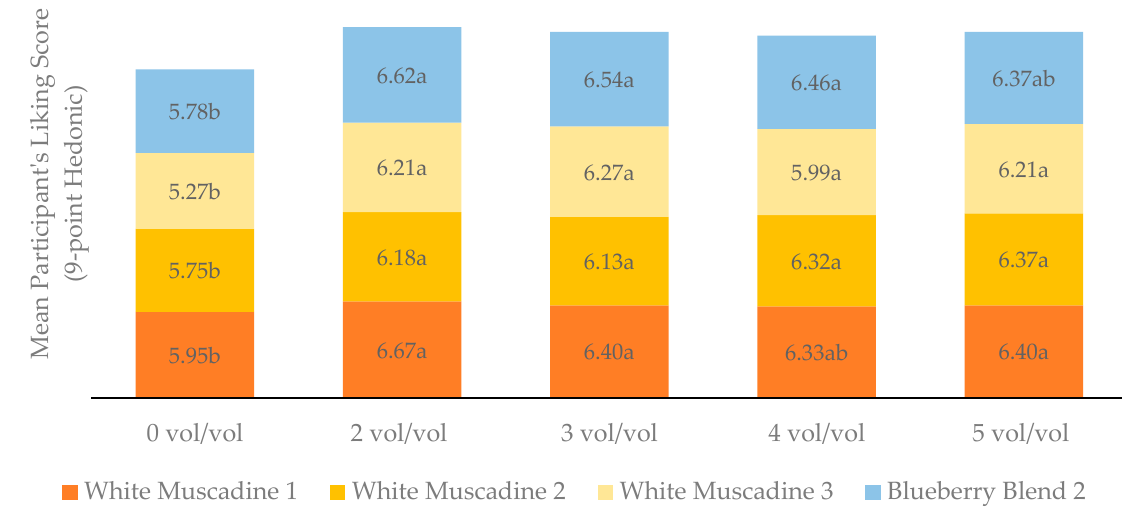
Figure 2. The mean liking using 9-point hedonic scale for each of the four Florida wines. a, b denotes statistical significance ( p < 0.05) for each individual wine between carbonation levels using Two-way ANOVA and Tukey’s HSD statistical tests.